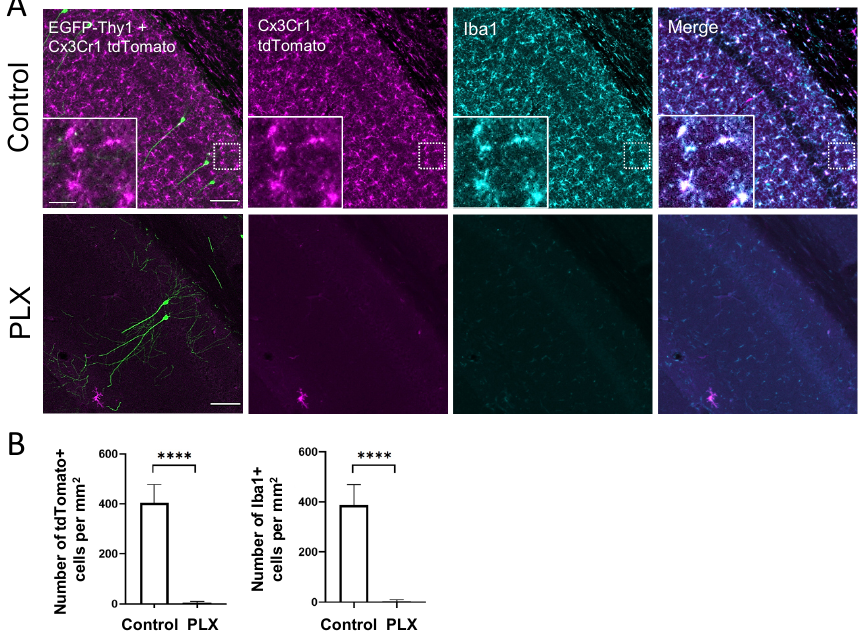
Figure 1. PLX treatment for 28 days leads to microglia depletion. ( A ) The confocal images show perfect colocalization of tamoxifen-induced tdTomato (magenta) signal in Cx3Cr1-expressing cells and immunohistochemical staining for microglial marker Iba1 (cyan) in the CA1 region of the hippocampus. Insets illustrate the typical microglial morphology of labeled cells. EGFP labels a small subset of pyramidal neurons (green), which were used for dendritic spine analysis. ( B ) The bar graphs display the efficacy of the oral PLX3397 administration. After 4 weeks of treatment, virtually all microglia are depleted from the hippocampus. **** p <0.0001, t -test. Scale bars are 100 µ m for main images and 25 µ m for